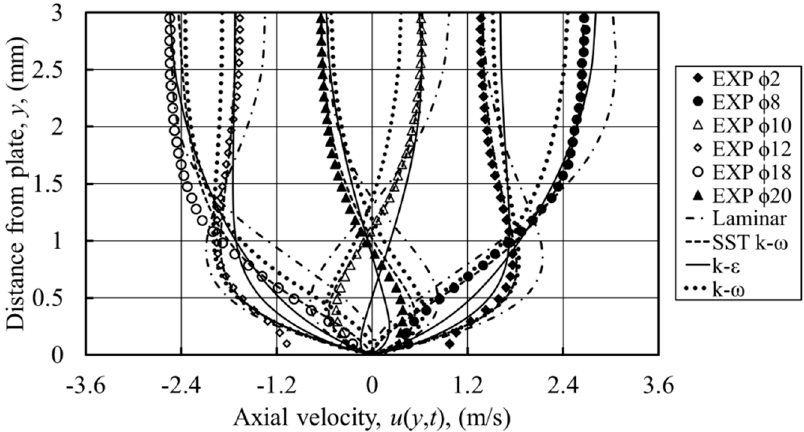
Figure 10. Comparison between velocity profiles from experiments and CFD for the location 10 mm from the joint, in the cold channel, for the drive ratio of 0.83%. SST stands for shear-stress-transport. Appl. Sci. 2017 , 7 , 673